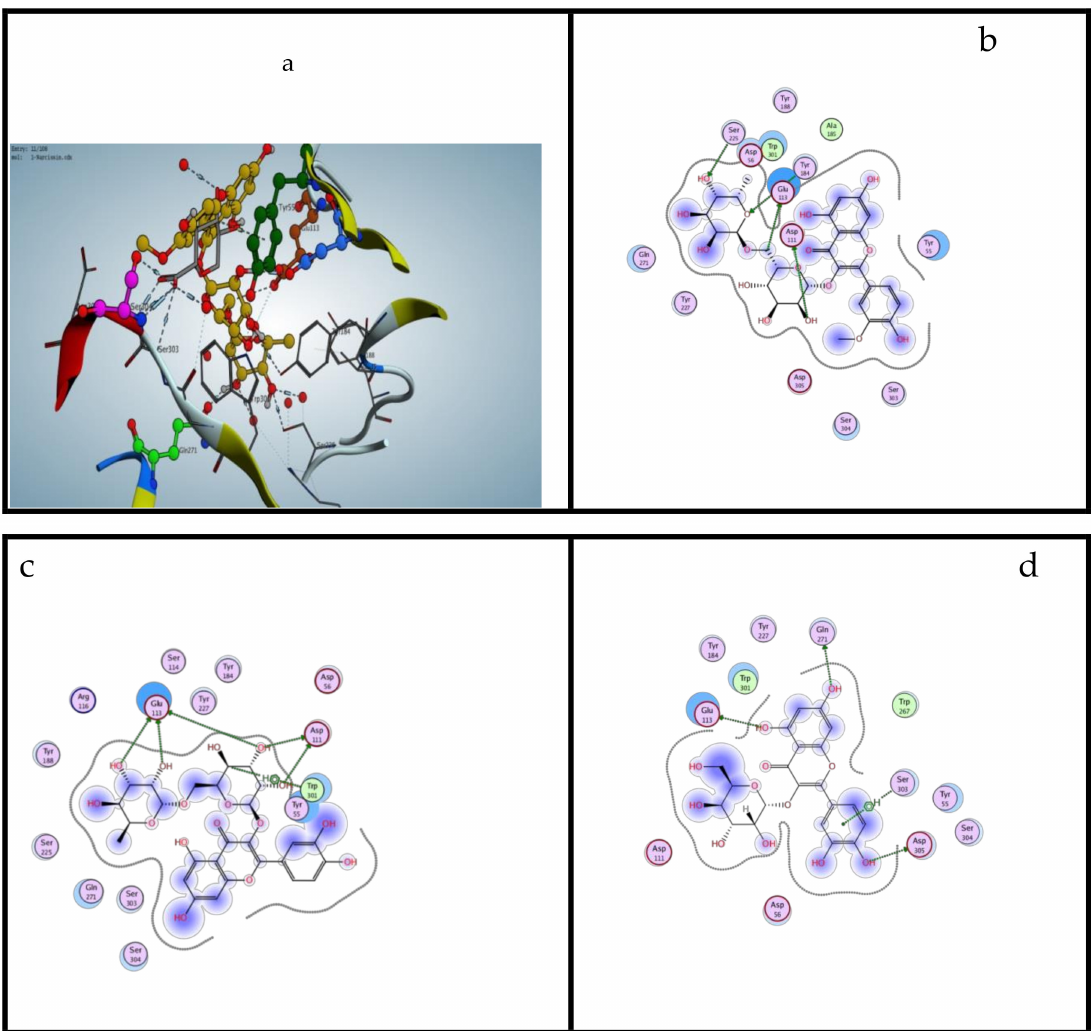
Figure 3. Docked poses relative or proportional to the minimum energy configuration for narcissin, rutin & quercetin binding to HAase. (Panel a ) Binding pattern of narcissin colored by element, ball and stick into HAase showing 4 hydrogen bond interactions (dotted lines). (Panel b – d ) displayed the most active flavonoids narcissin ( b ), rutin ( c ) and quercetin ( d